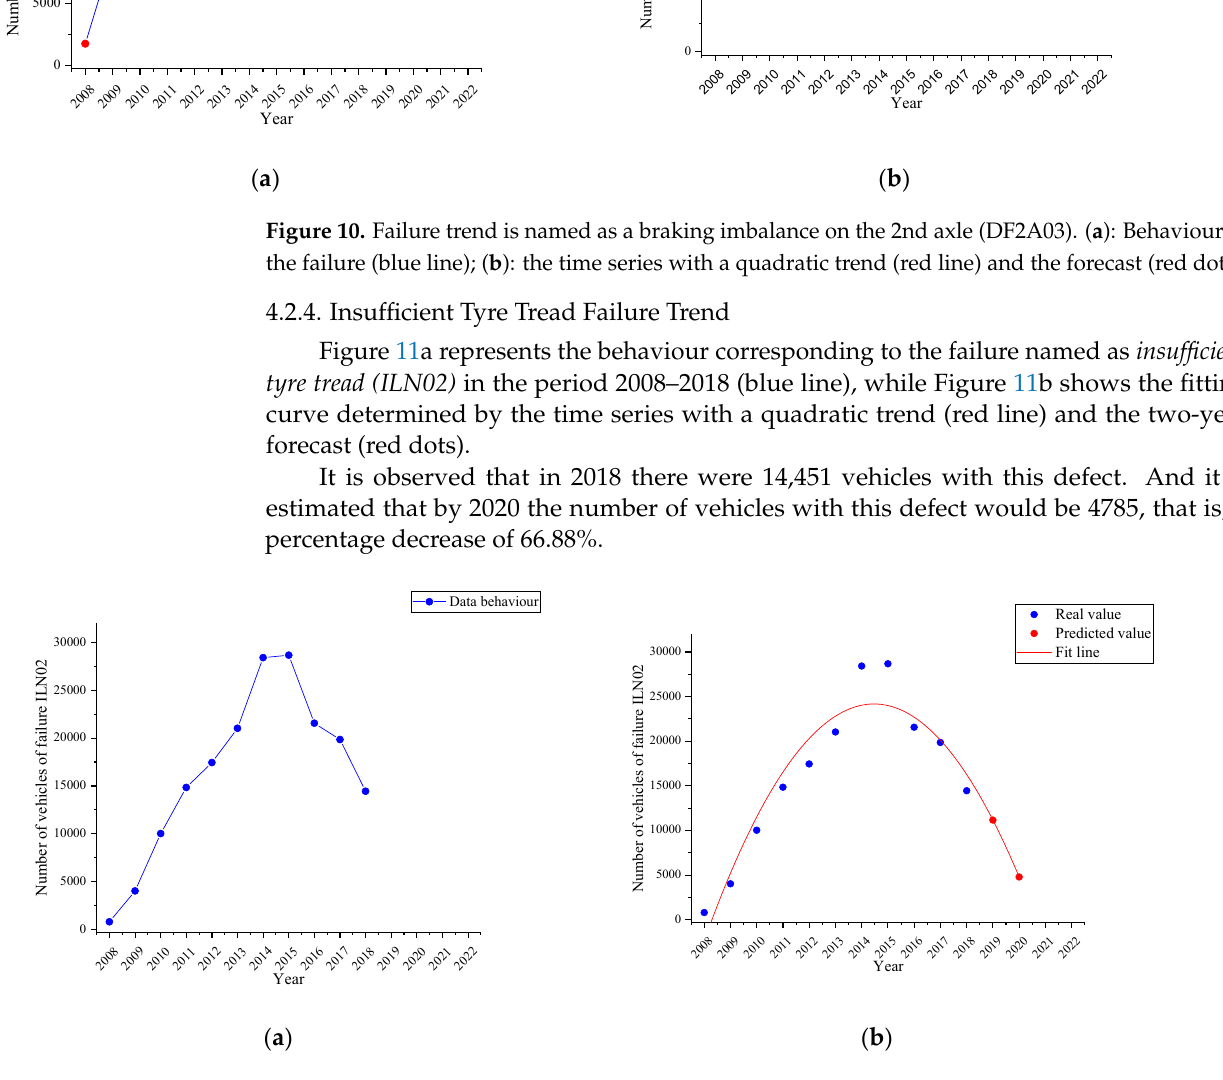
Figure 11. Failure trend named as insufficient tyre tread (ILN02). ( a ): Behaviour of the failure (blue line); ( b ): the time series with a quadratic trend (red line) and the forecast (red dots).